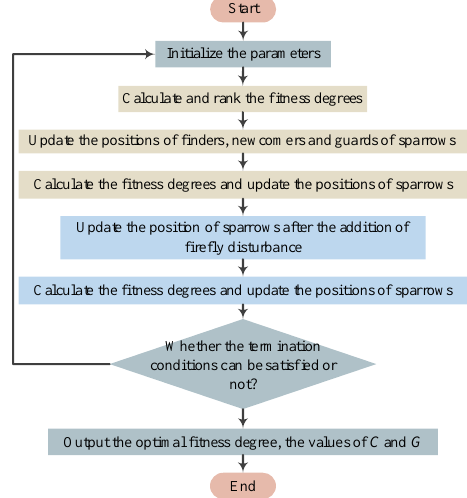
Figure 7. Flow chart of SVM optimized by SSA modified by FA.